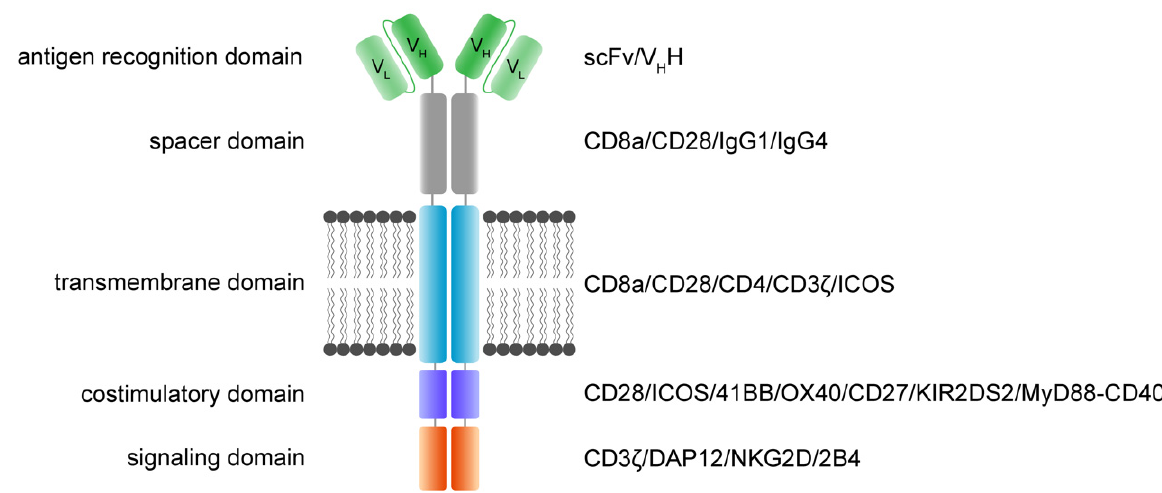
Figure 1. Functional modules of CAR receptors.